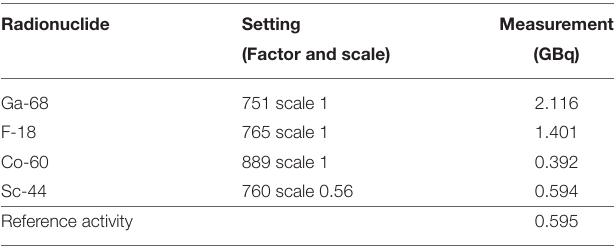
TABLE 1 | Reference activity and employed factors for determination of the local dose calibrator factor for 44 Sc measurements. Radionuclide